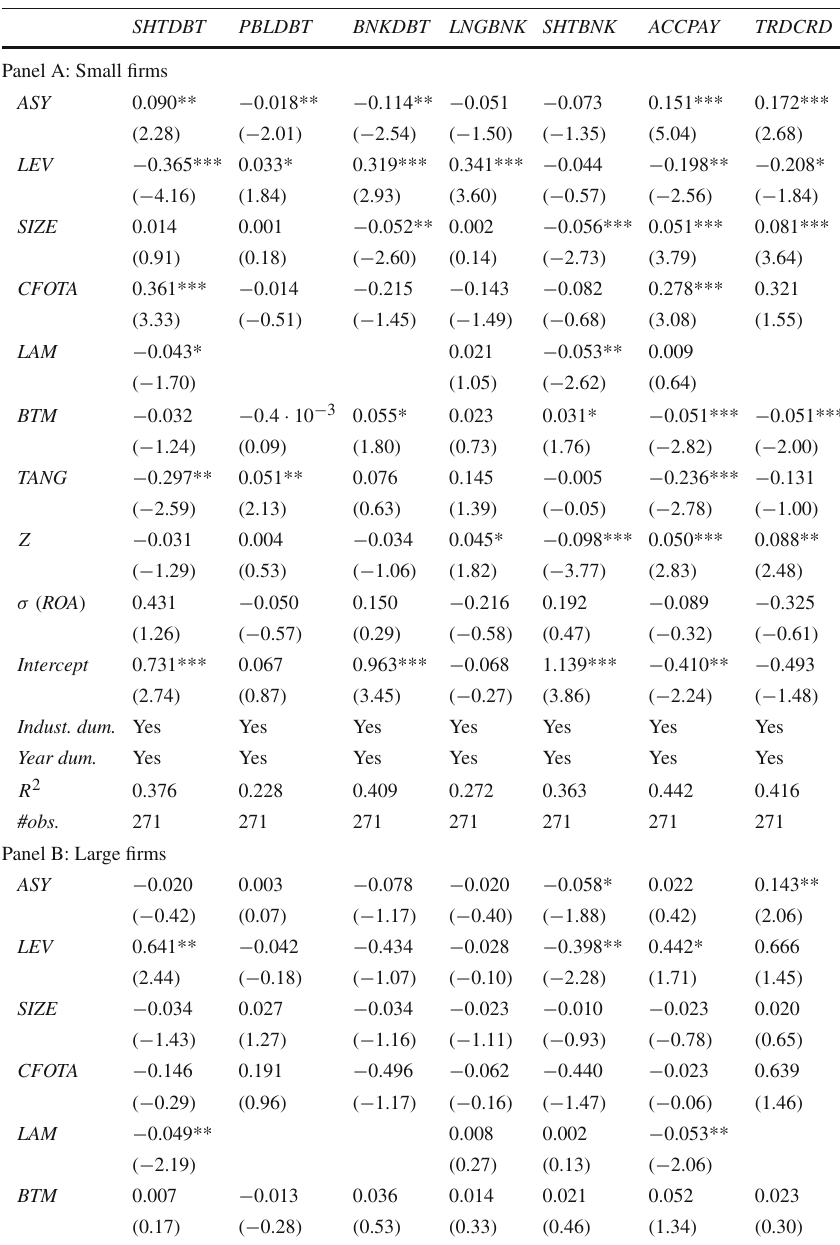
Table 7 Effect of information asymmetry on different types of debt by